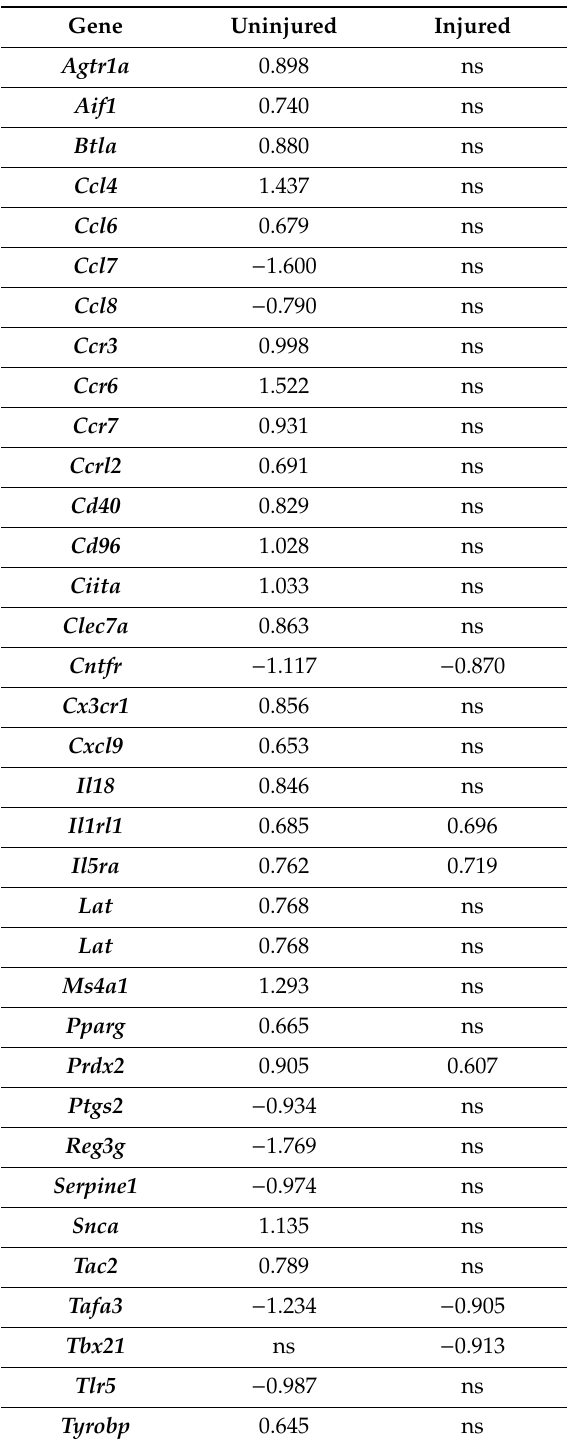
Table 1. Inflammatory gene overlap between the AB and VEH groups, showing the expression levels. Fold change (log2 scale) values are shown in the table (FDR < 0.05 for all genes). Changes that were not significant are denoted as